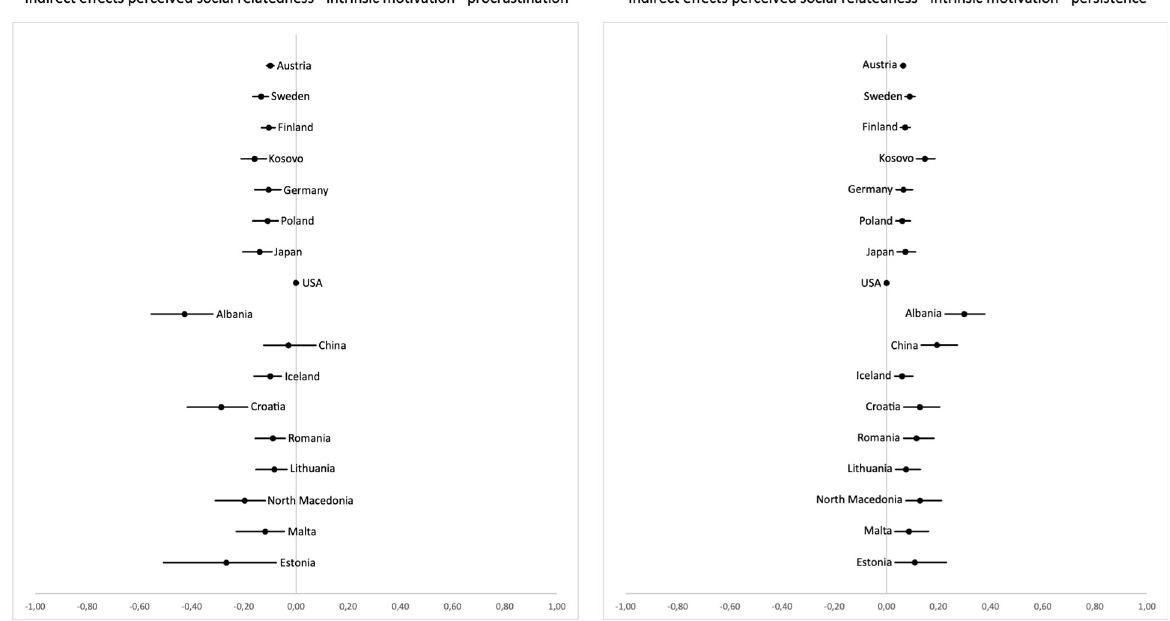
Fig 6. Unstandardized coefficients and two-sided 5% confidence intervals for the indirect effects of perceived social relatedness on procrastination (left) and persistence (right), mediated by intrinsic motivation. Countries are ordered by sample size from top (highest) to bottom